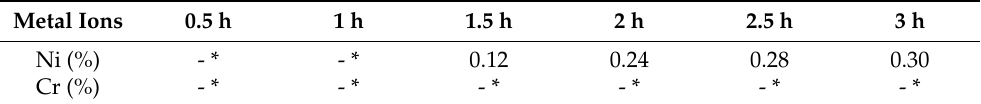
Table 4. Dissolution of metal of Ni/Cr(2/1) − 0.5LA LDH in aqueous solution. Metal